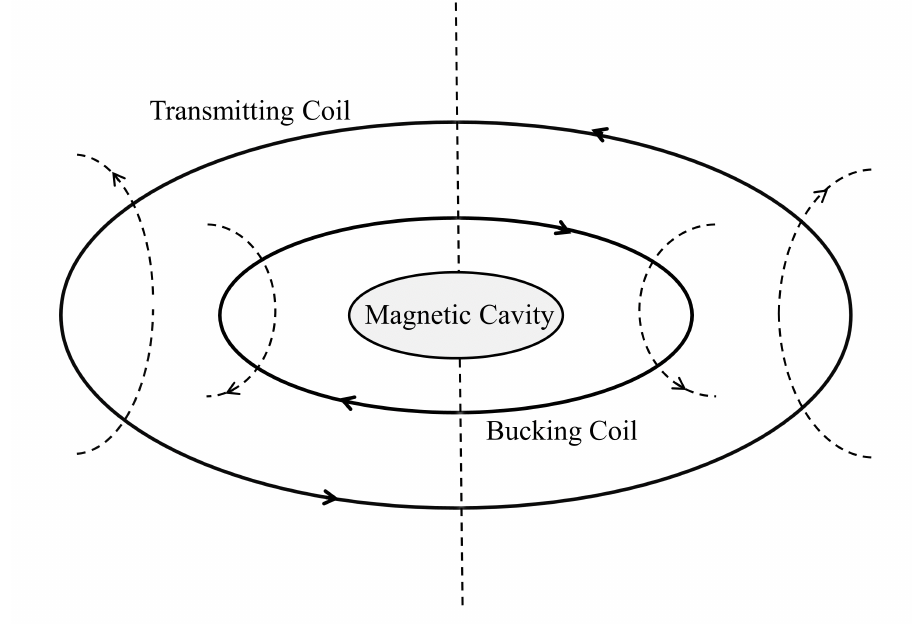
Figure 5. Schematic diagram of the central magnetic